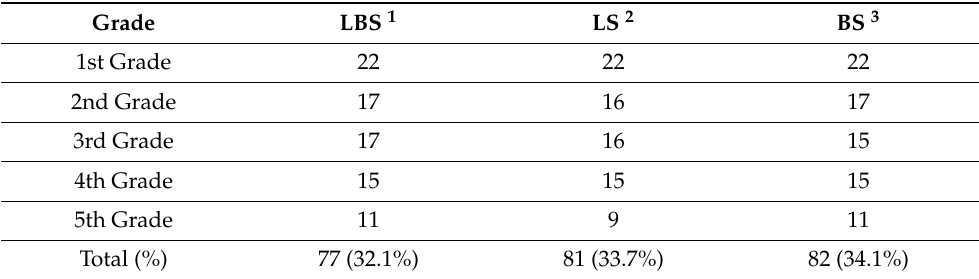
Table 2. Number of subjects per grade and subgroups of gross motor skills